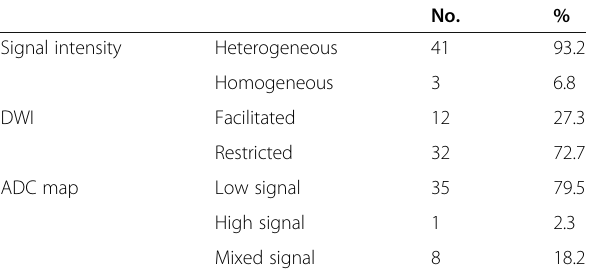
Table 4 Signal intensity of the studied cases by MR sequences, DW, and ADC